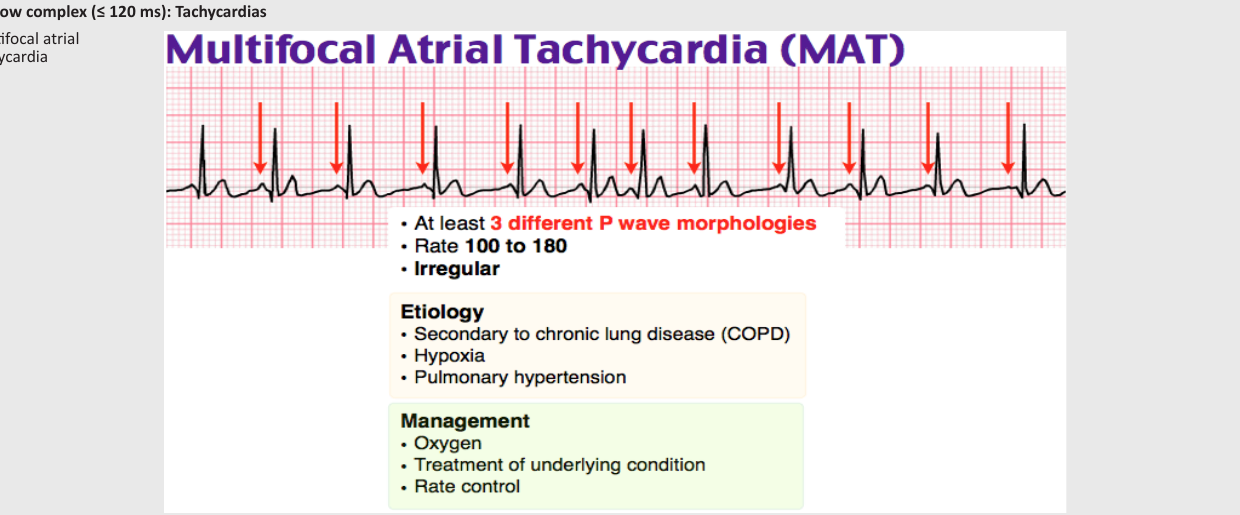
TABLE 2: Some treatments for arrhythmias. Disorder Treatment